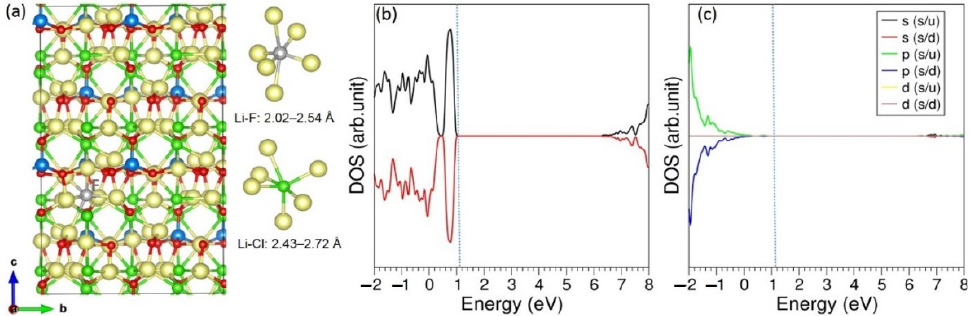
Figure 9. ( a ) Relaxed structure of F-doped Li 6 SiO 4 Cl 2 , ( b ) DOS plot, and ( c ) atomic DOS plot of F.